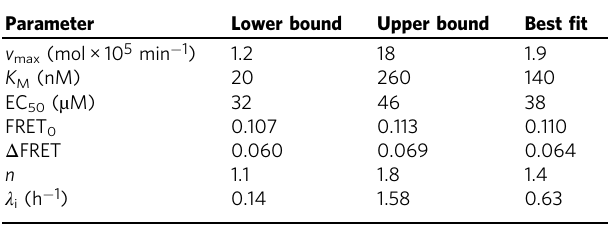
Table 1 Parameters of the PhrA signaling network in Bacillus subtilis